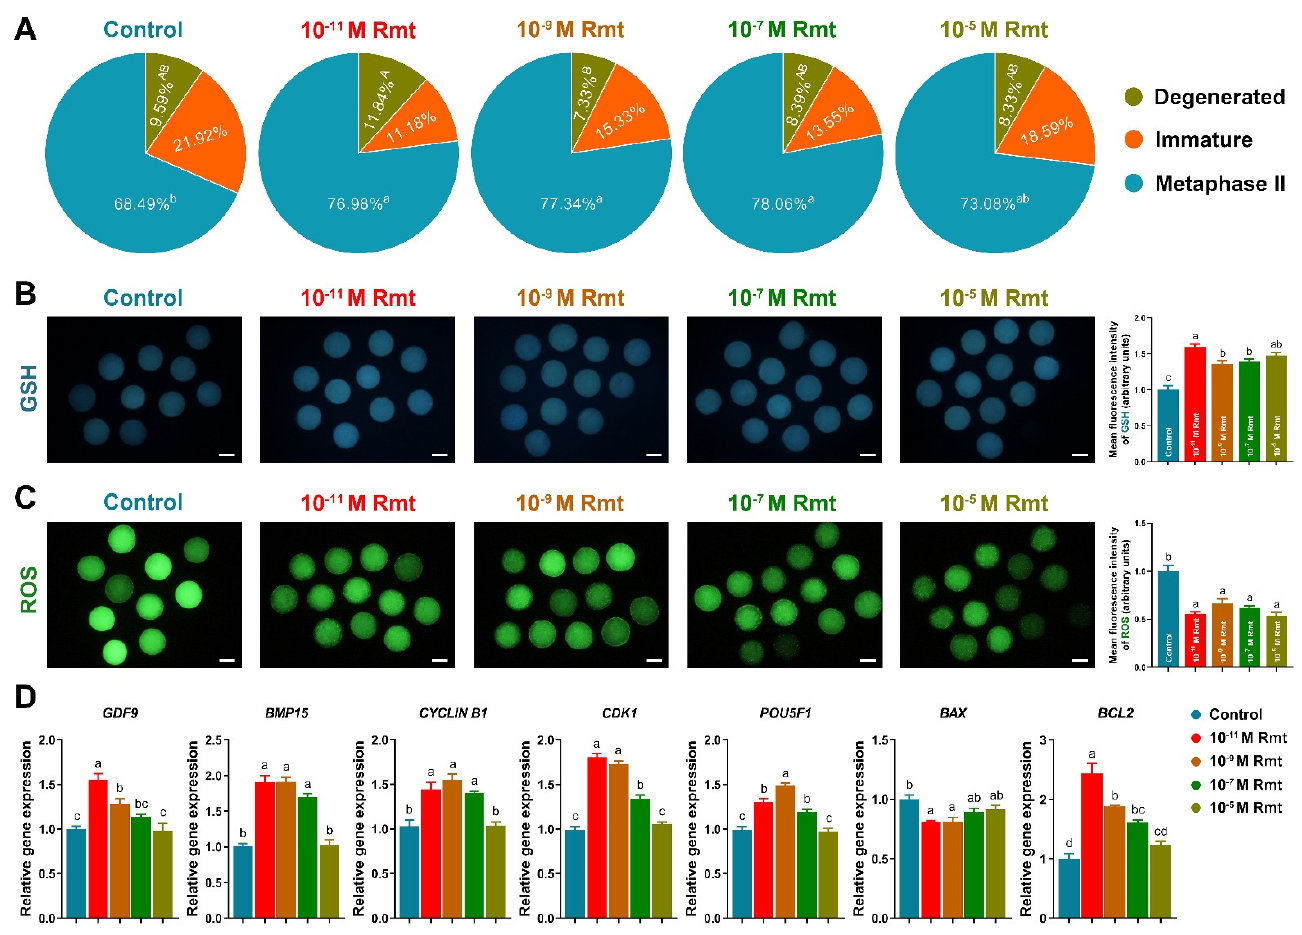
Figure 2. Effects of ramelteon on porcine oocyte nuclear and cytoplasmic maturation. ( A ) Nuclear maturation rate; ( B , C ) level of GSH and ROS; ( D ) oocyte development-related gene expression. Different letters denote significant difference ( p < 0.05). Results are shown as the average ± SEM of at least three repeats of independent experiments. Rmt, Ramelteon. Scale bars = 100 µM.